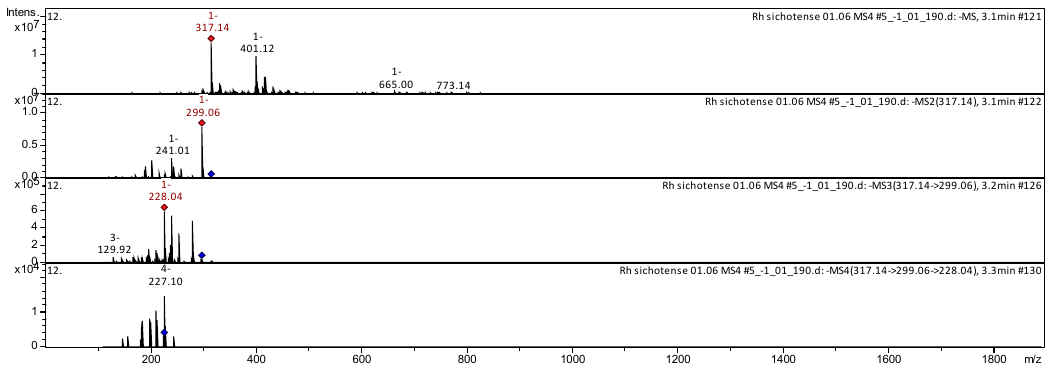
Figure 9. CID spectrum of myricetin from Rh. sichotense , m / z 317.14.